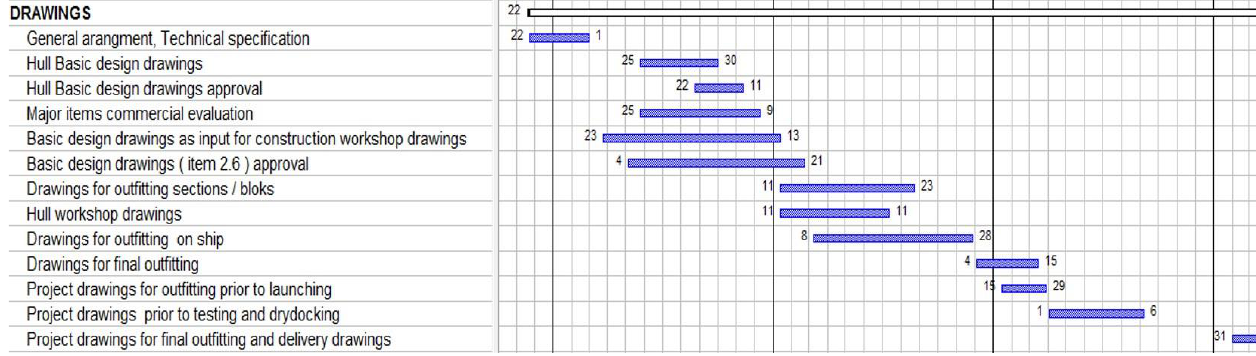
Figure 2. Design process: deliverables dependencies.